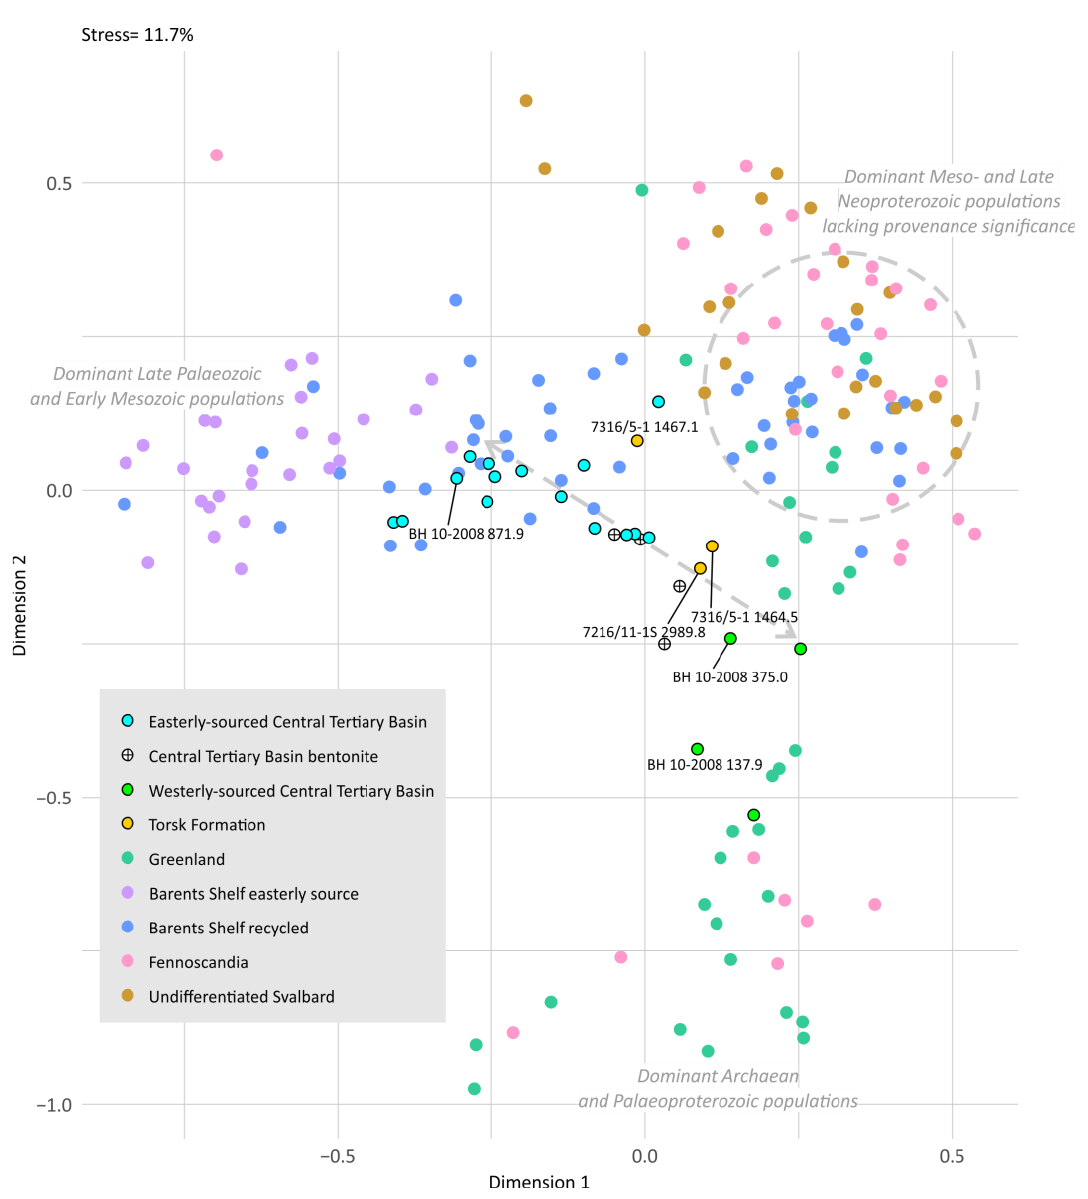
Figure 11. Multi-dimensional scaling (MDS) plot of detrital zircons from samples collected from the Barents Shelf region. Data are simplified to show the inferred sediment source and/or location of the successions. Plot constructed following Vermeesch [92] and Vermeesch et al. [93] and is constructed from data obtained from 186 samples [13,16,27,45–48,90,94–111] from the Barents Shelf and adjacent regions. The goodness of fit, describing how well the data can be represented on a 2D plane, is indicated by the stress value. Stress values of this magnitude are considered fair [112]. Data from the Central Tertiary Basin and the Torsk Formation are highlighted by points with bold outlines, and those obtained in this study are labelled. The grey dashed ellipse represents samples with dominant Mesoproterozoic-Late Neoproterozoic populations, because of which their recycled nature have been shown to have reduced provenance significance in this region of the Arctic [83] and the grey arrowed line represents a mixture between north Greenland and Barents Shelf sources.